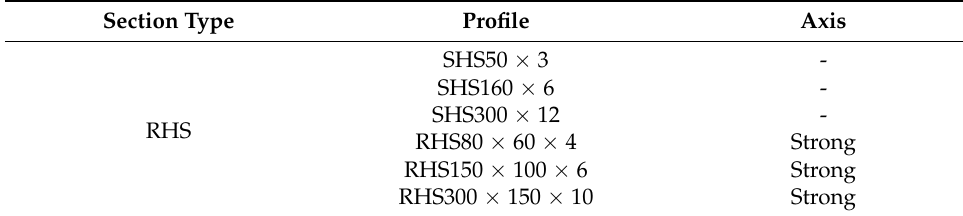
Table 1. Sections used for numerical modelling.